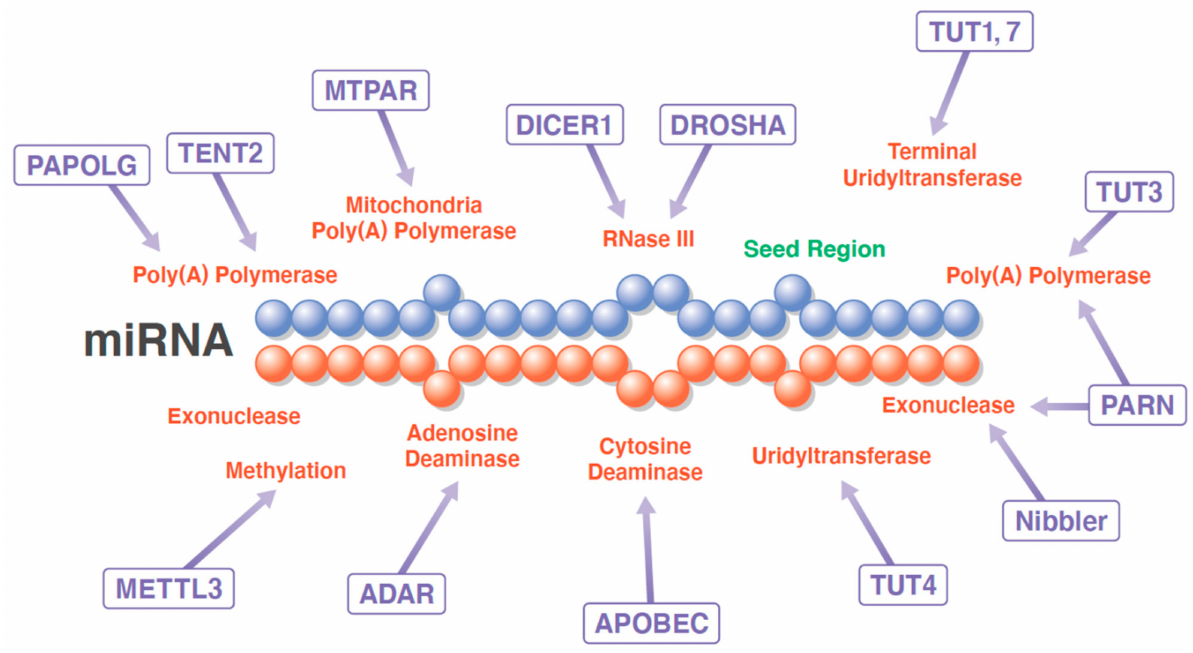
Figure 2. Generation of isomiR. Enzymes affecting the length, sequence, and modifications of miRNAs are: ADAR, adenosine deaminase RNA specific; APOBEC1, apolipoprotein B mRNA editing enzyme catalytic subunit; DICER1, dicer 1, ribonuclease III; DROSHA, drosha ribonuclease III; METTL3, methyltransferase-like protein 3; MTPAR, mitochondrial poly(A) polymerase; Nibbler, exonuclease 3 (cid:48) –5 (cid:48) domain containing 3; PAPOLG, poly(A) polymerase gamma; PARN, poly(A)- specific ribonuclease; TENT2, terminal nucleotidyltransferase 2; TUT1, terminal uridylyltransferase 1; TUT3, terminal nucleotidyltransferase 4B; TUT4, terminal uridylyltransferase 4; and TUT7, terminal uridylyltransferase